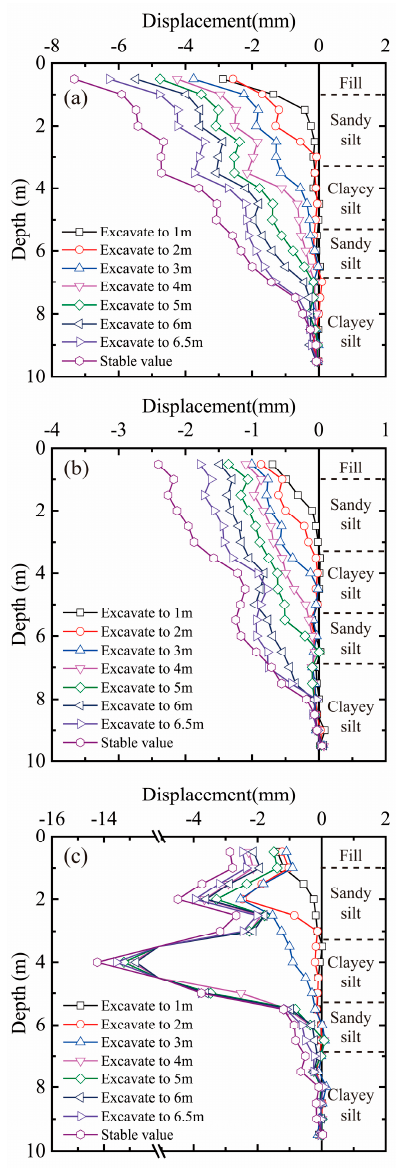
Figure 11. Measured lateral displacement: ( a ) T1; ( b ) T2; and ( c ) T3.